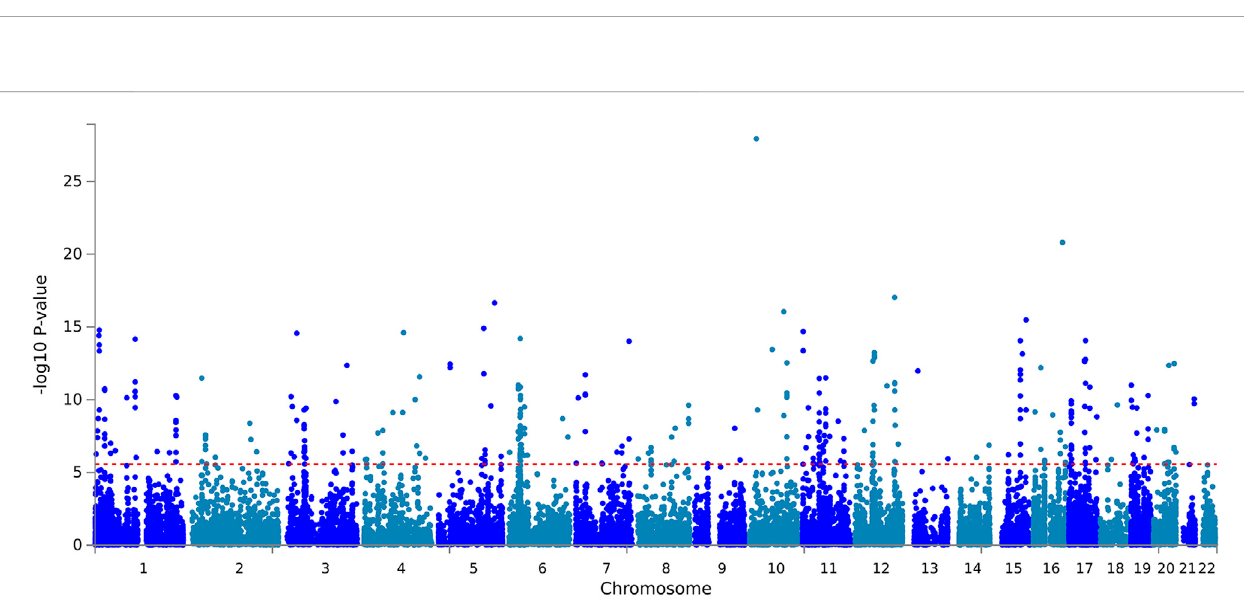
GWAS summary statistics, signi fi cant genes identi fi ed by the MAGMA gene-based test were plotted on a Manhattan map (Figure 2). MAGMA ’ s gene-set analysis tested 15,483 gene sets using the default competitive testing model, with the top 10 gene sets provided in Supplementary Table S6. The top three most signi fi cant pathways were positive regulation of gene expression ( p = 7.37E - 07), positive regulation of biosynthetic process ( p = 1.22E - 06), and positive regulation of RNA biosynthetic process ( p = 1.50E - 06). It is suggested that hypertension is associated with gene